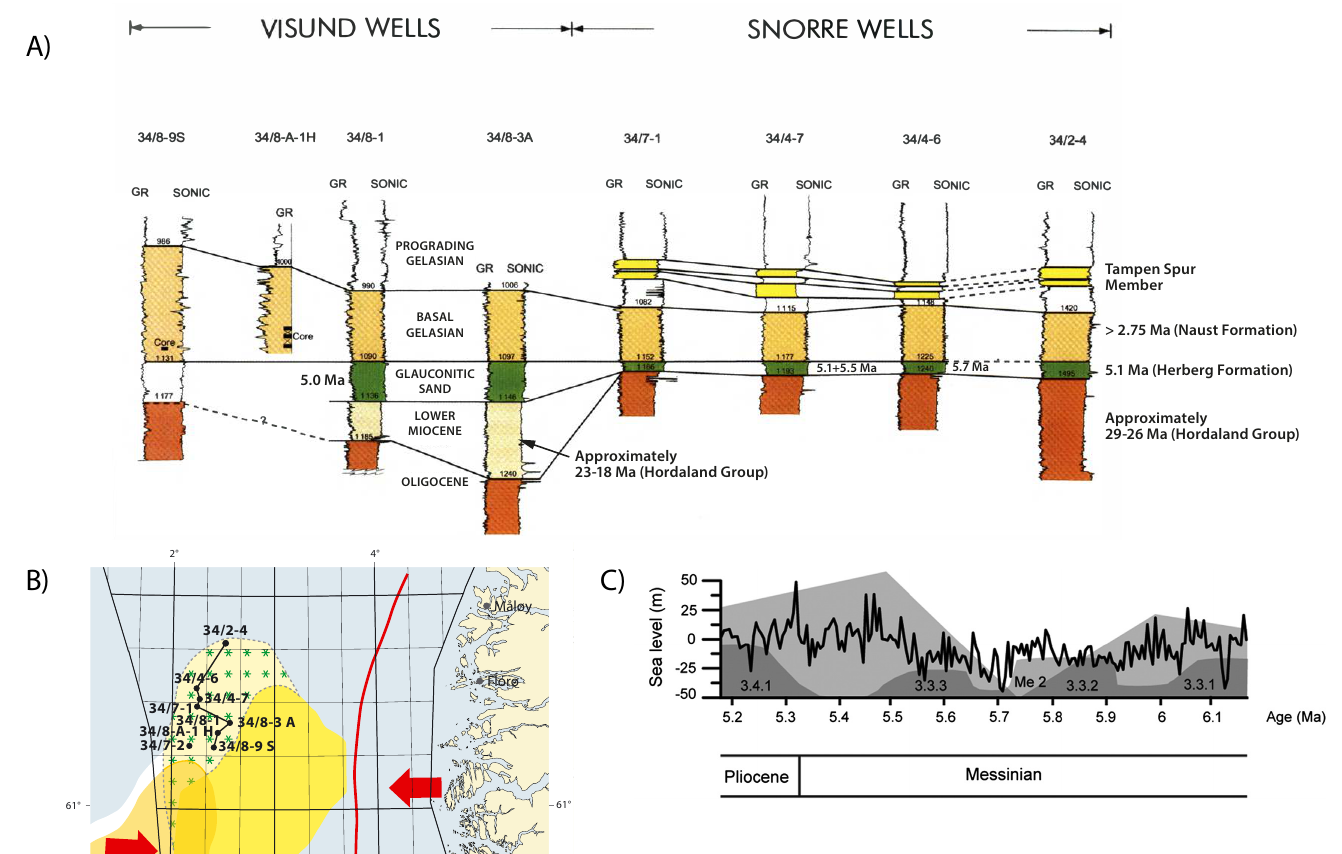
Figure 21. (A) Log correlation diagram of wells from the Visund area (block 34/8), wells from the Snorre area (block 34/4 and 34/7) and well 34/2–4 on the northern Tampen Spur (northernmost North Sea; modified after Eidvin & Rundberg, 2001). (B) Distribution of the Bjørge and Herberg formations (former Utsira Formation) in the Snorre and Visund Field areas at Tampen. Light and dark yellow areas show outline of the Bjørge Formation quartzose sands. Hatched area (with green stars) shows assumed outline of thin glauconitic Herberg Formation extending beyond the Bjørge Formation. Red lines show top Oligocene truncation, and red arrows show sediment transport directions (modified after Eidvin & Rundberg, 2001; Rundberg & Eidvin, 2005). (C) Global sea-level curves of Hardenbol et al. (1998; light grey shading) and Miller et al. (2005; black line), as well as the 4th-order eustatic cycles of Esteban et al. (1996; dark grey shading) (modified after Pérez-Asensio, 2013). Note that the glauconitic sand of the Herberg Formation was deposited coevally with the period of transgression after the Messinian lowstand. However, it should be noted that the Sr-data from the glauconitic sand in well 34/7–2 (Tordis Field) gave 4.7–4.2